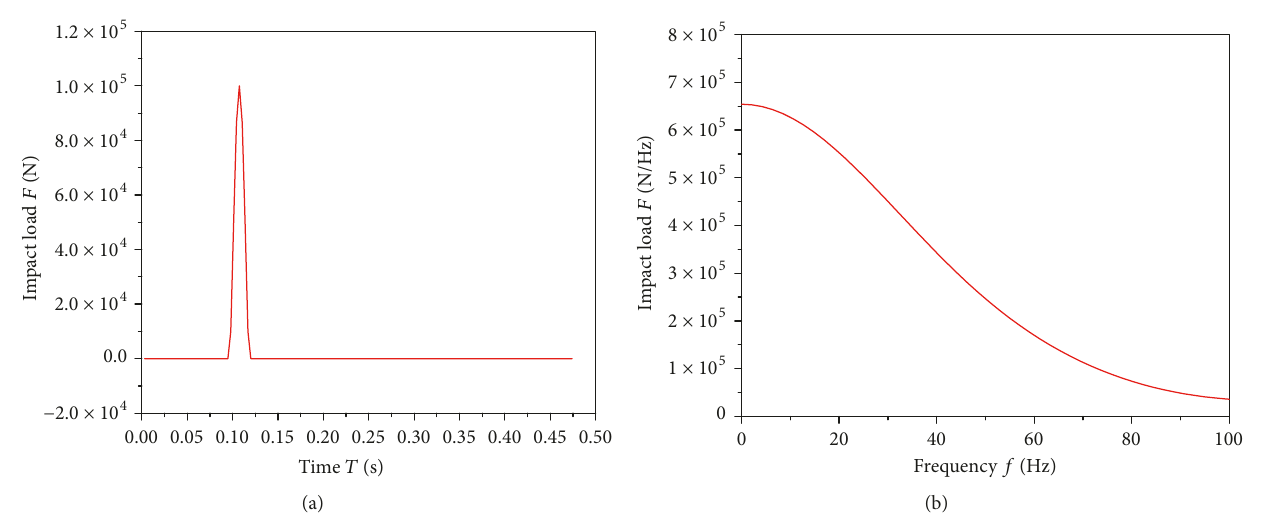
Figure 7: (a) Time history and (b) Fourier spectrum of the impact